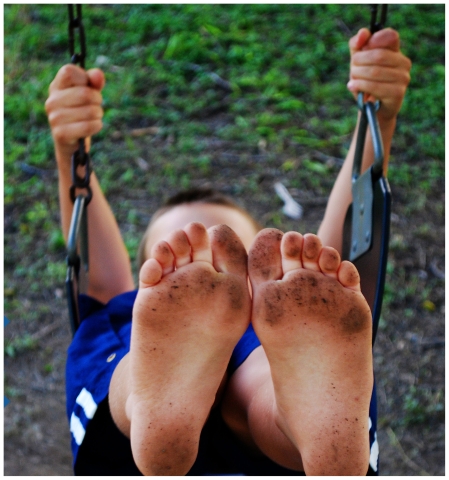
400 ppmSoil lead concentration at which the EPA recommends remediation of bare soil in children’s play areas1,200 ppmSoil lead concentration at which the EPA recommends remediation of bare soil in other home areas